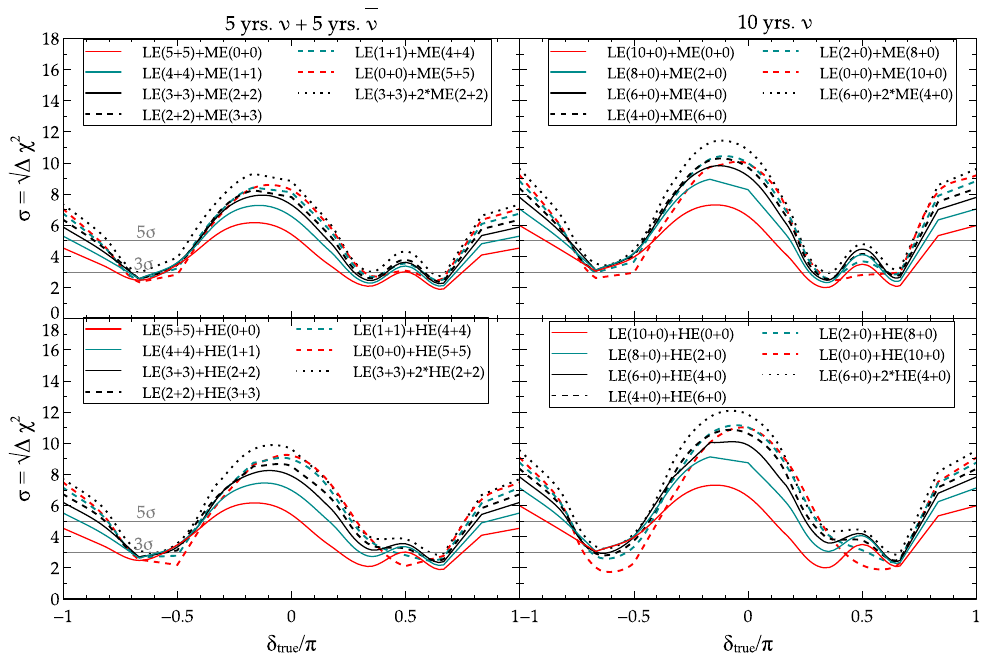
Figure 22.3: Separation between SI and NSI events at DUNE with different beam tunes at χ 2 level. A CP conserving NSI scenario is assumed. The left column shows 5 years of neutrino and 5 years of anti-neutrino run times, while the right column depicts the case of 10 years of neutrino run time only. The plot is taken from [ 377 ] . (iii) Impact of beam tunes on extricating physics scenarios via the fraction plots :- Another im- portant factor driving the sensitivity to SI-NSI separation is the fraction of values of CP phase for which the sensitivity is more than 3 σ or 5 σ . In Fig. 22.4, the fraction of δ values for which the sensitivity lies above 3 σ (magenta) and 5 σ (blue) is plotted as a the panels are for a total run time of 10 years : the left one showing the case of 5